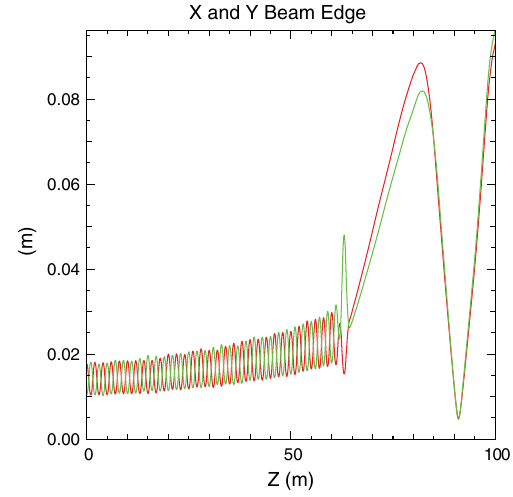
FIG. 3. Beam envelope (twice rms) as a function of z (red is x and green is y